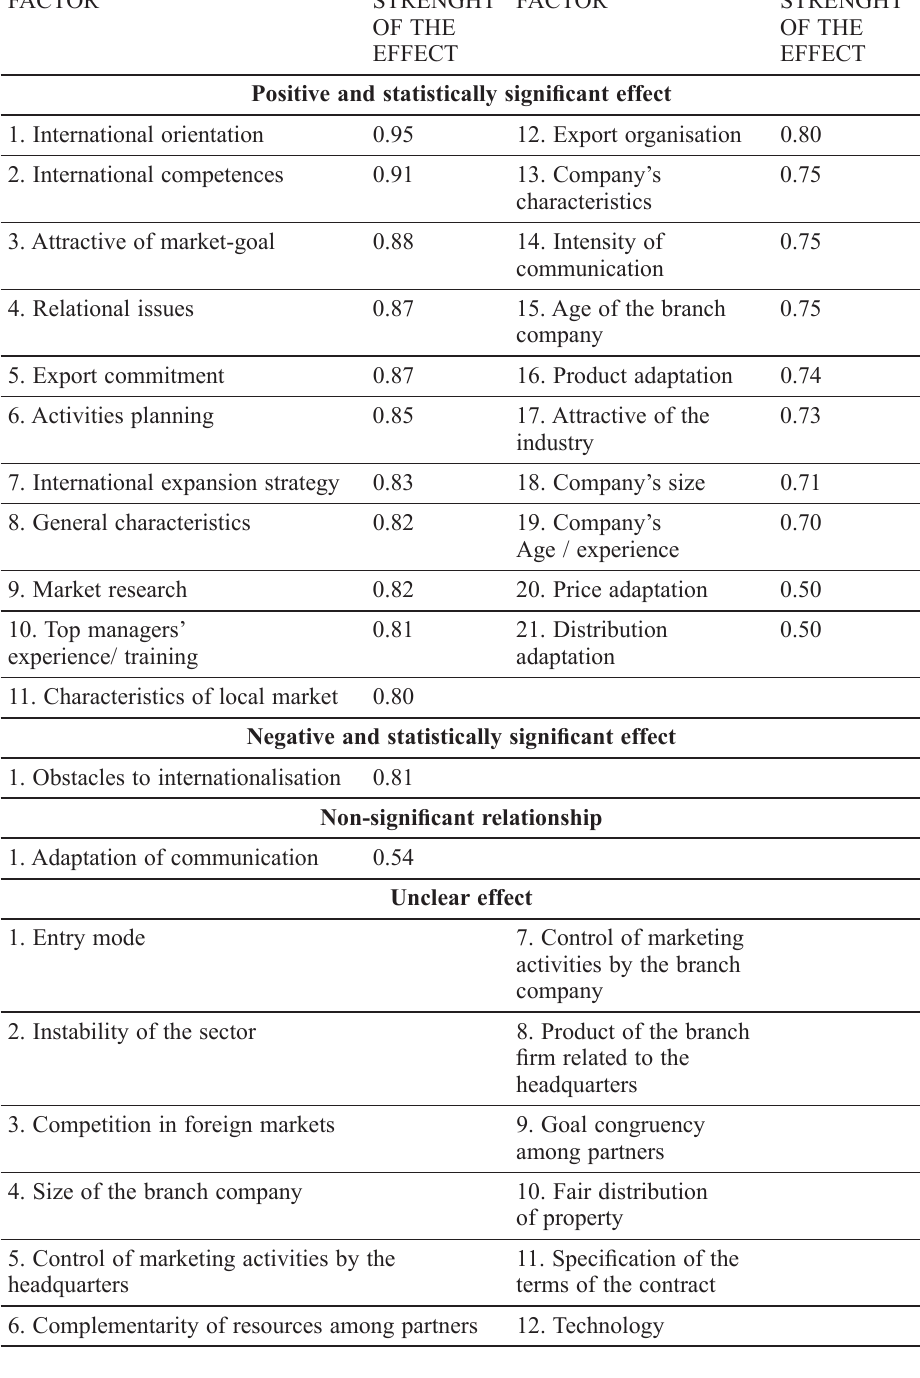
Table 2. Determinant factors on export performance (period 1998–2005) FACTOR STRENGHT OF THE OF